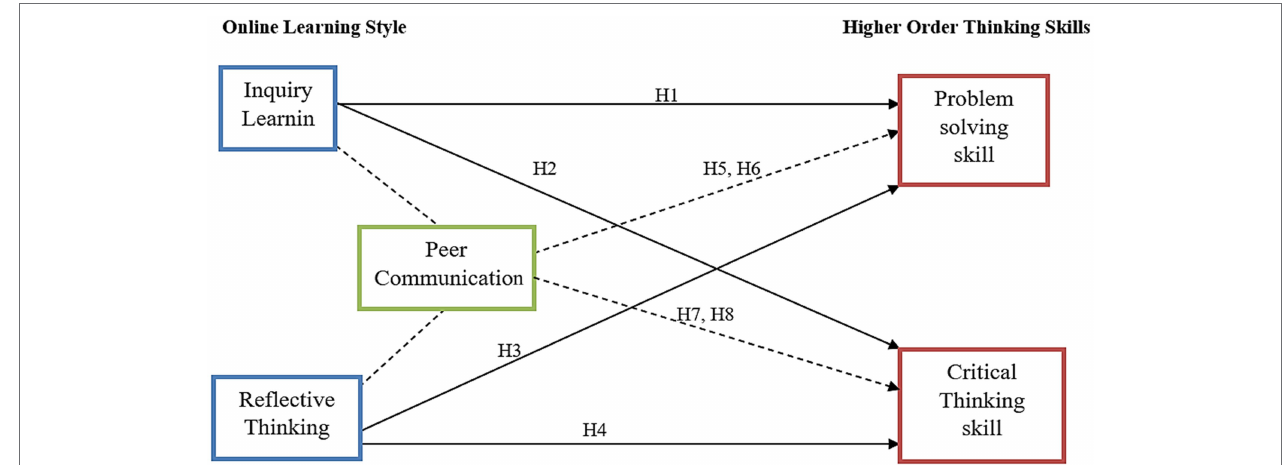
FIGURE 1 | Theoretical